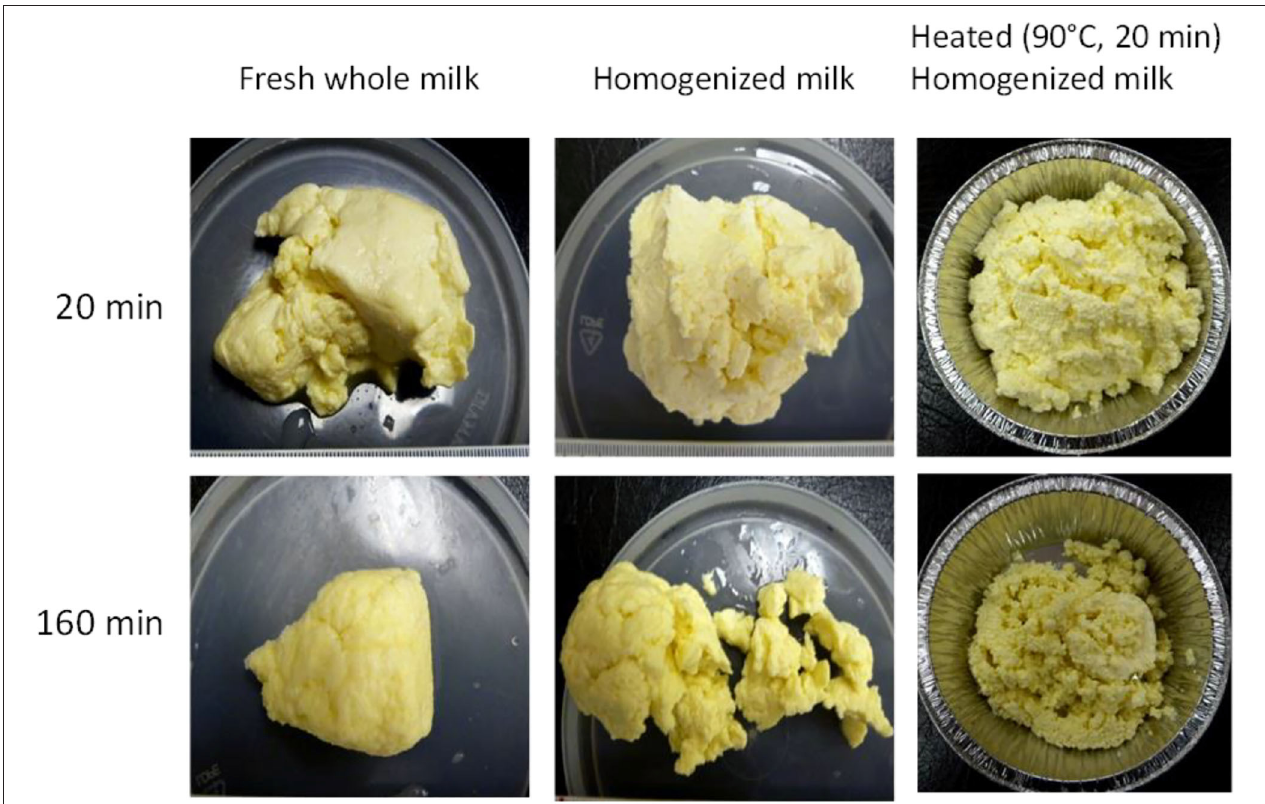
FIGURE 5 | Images of clots formed during the gastric digestion of raw (unheated), homogenized, and heated homogenized cattle whole milk during 20 and 160min of gastric digestion. Source: Adapted from Ye et al.